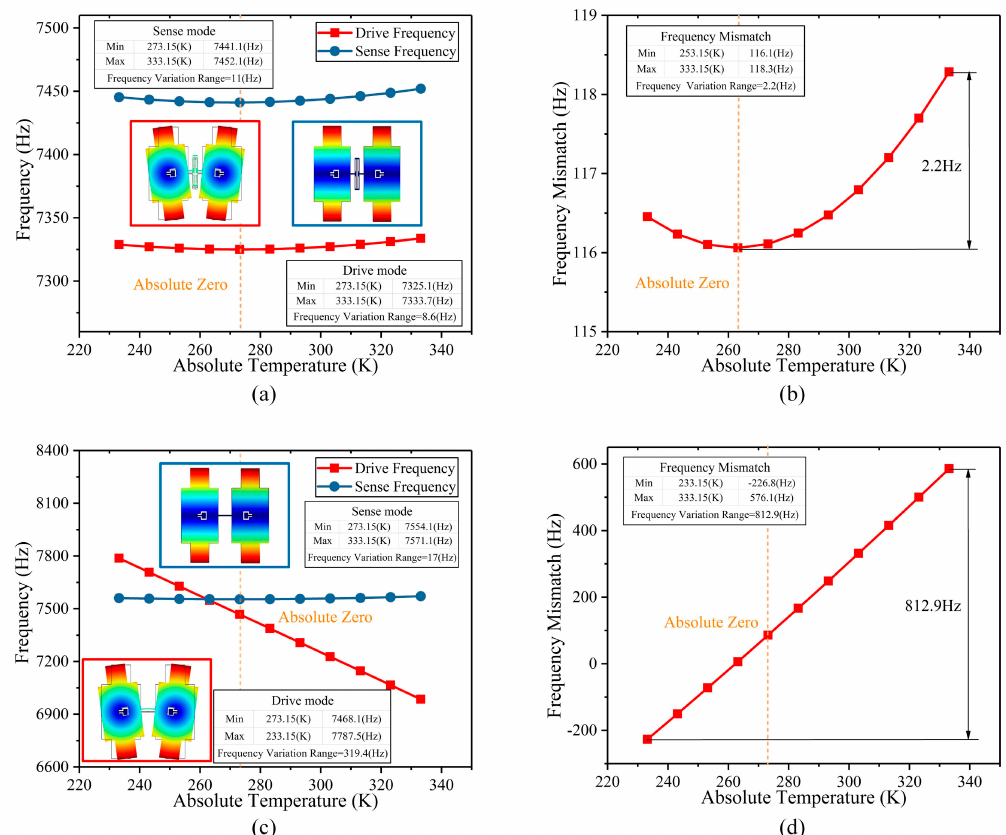
Figure 11. The changes of the operating frequency and frequency mismatch of the BFVG with or without the new stress-released structure ( a ) The variation of the operating frequency with the new stress-released structure; ( b ) the variation of the frequency mismatch with the new stress-released structure; ( c ) the variation of the operating frequency without the new stress-released structure; ( d ) the variation of the frequency mismatch without the new stress-released structure.